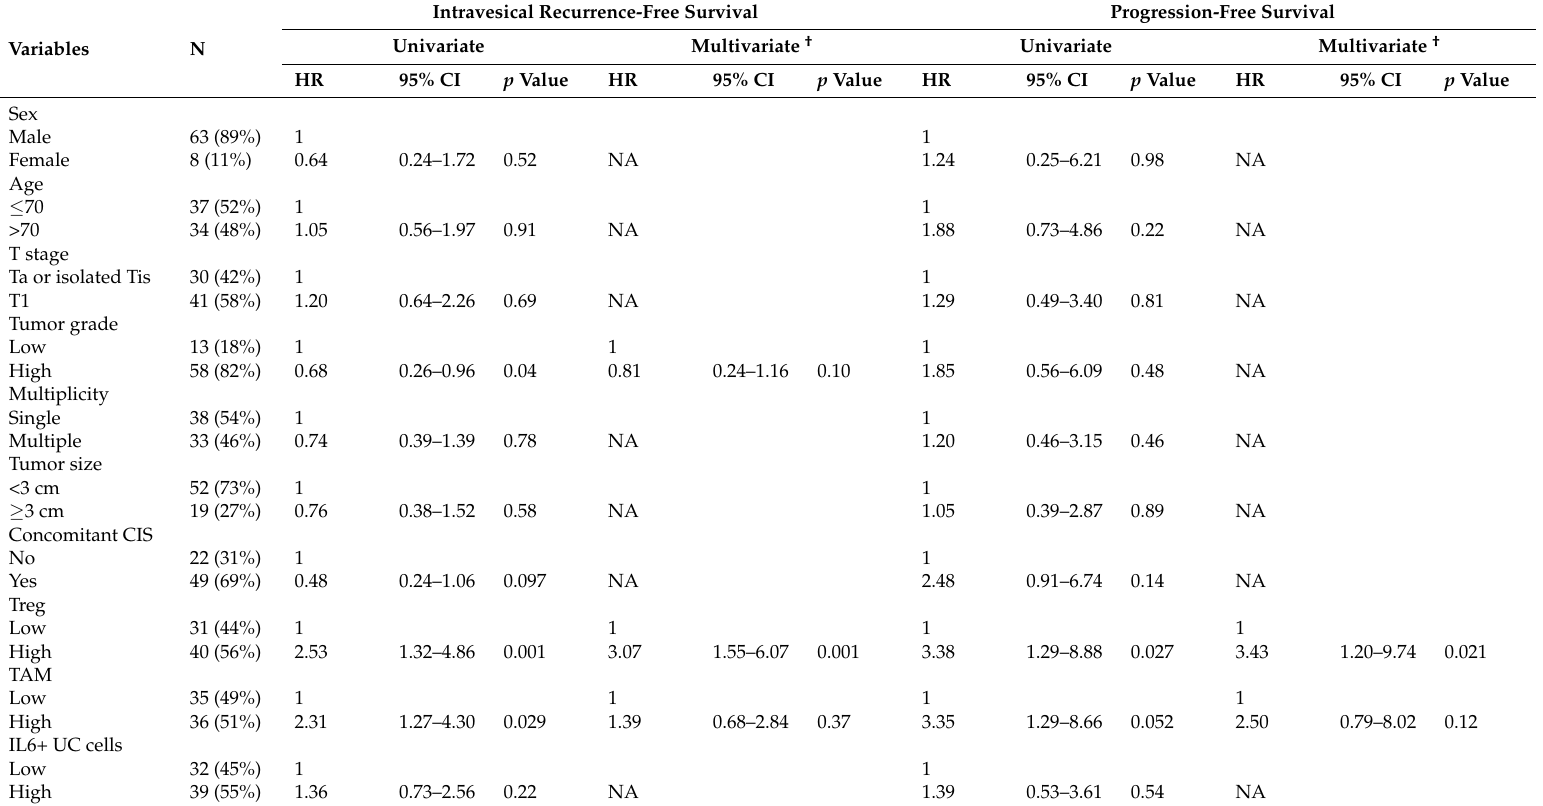
Table 2. The prognostic factors for recurrence and progression in 71 NMIBC patients treated with